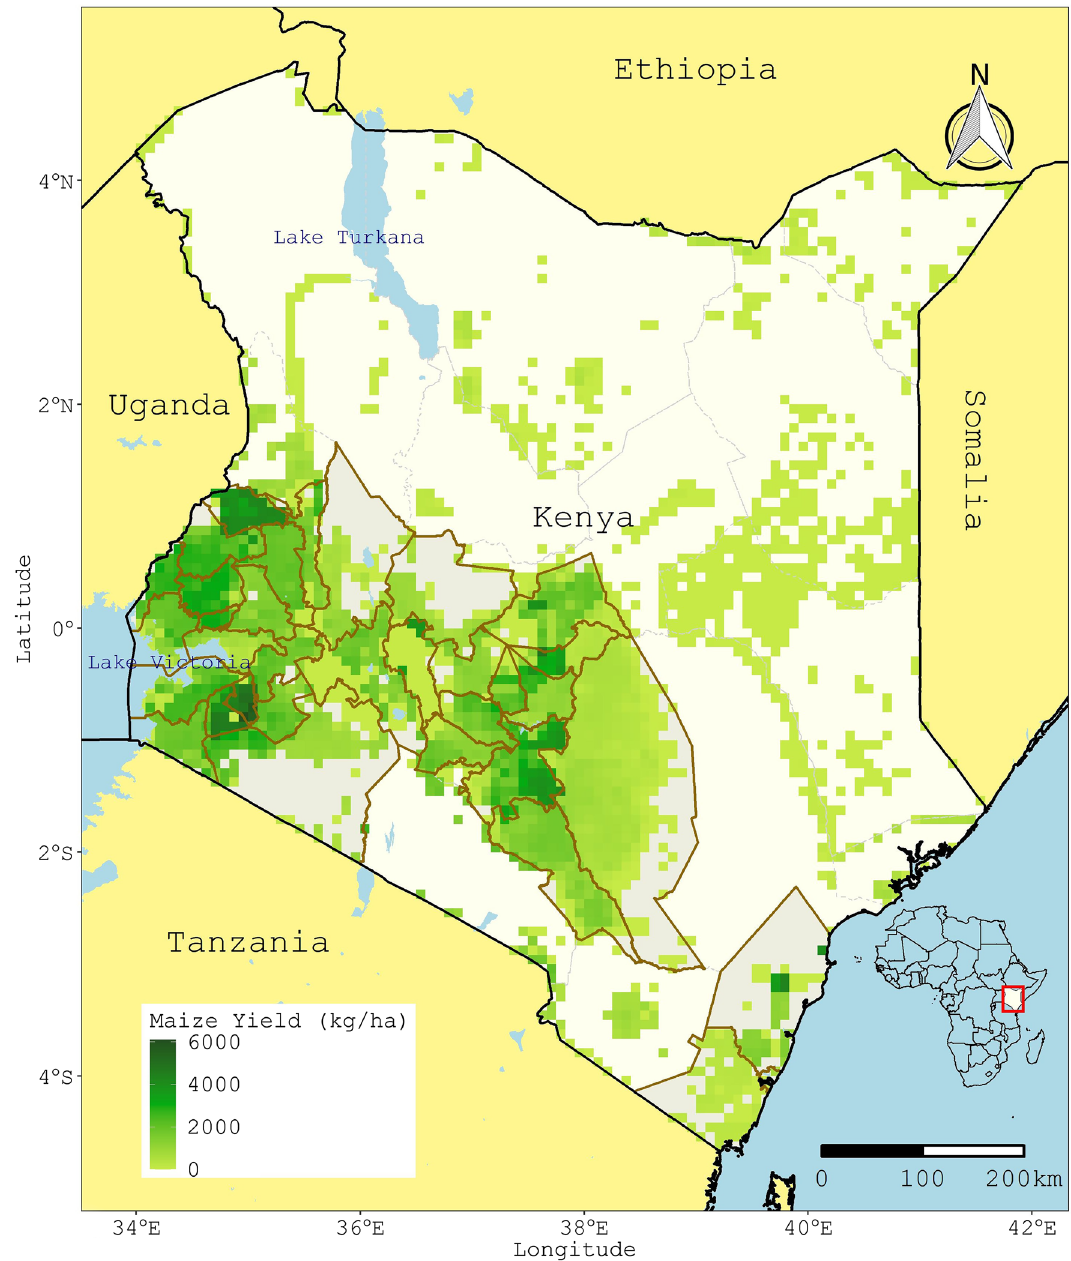
Figure 3. Maize cultivation and survey counties. Gridded maize yield data (the year 2010) came from IFPRI 36 . The 32 counties covered by the survey are highlighted in light grey with dark brown boundaries, while the other counties have dashed boundaries. Generated using ggplot2 package (version 3.3.5) R version 4.1.2 (Rstudio version 2022.02.0 + 443 in windows